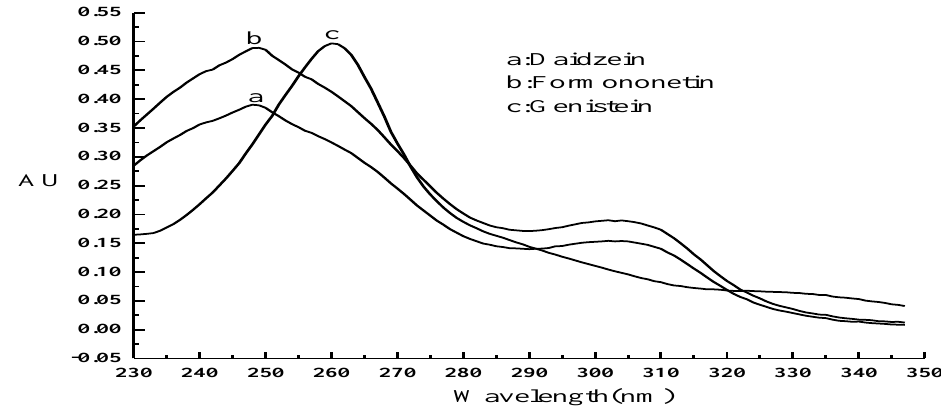
Figure 2. UV spectra of formononetin, daidzein and genistein.